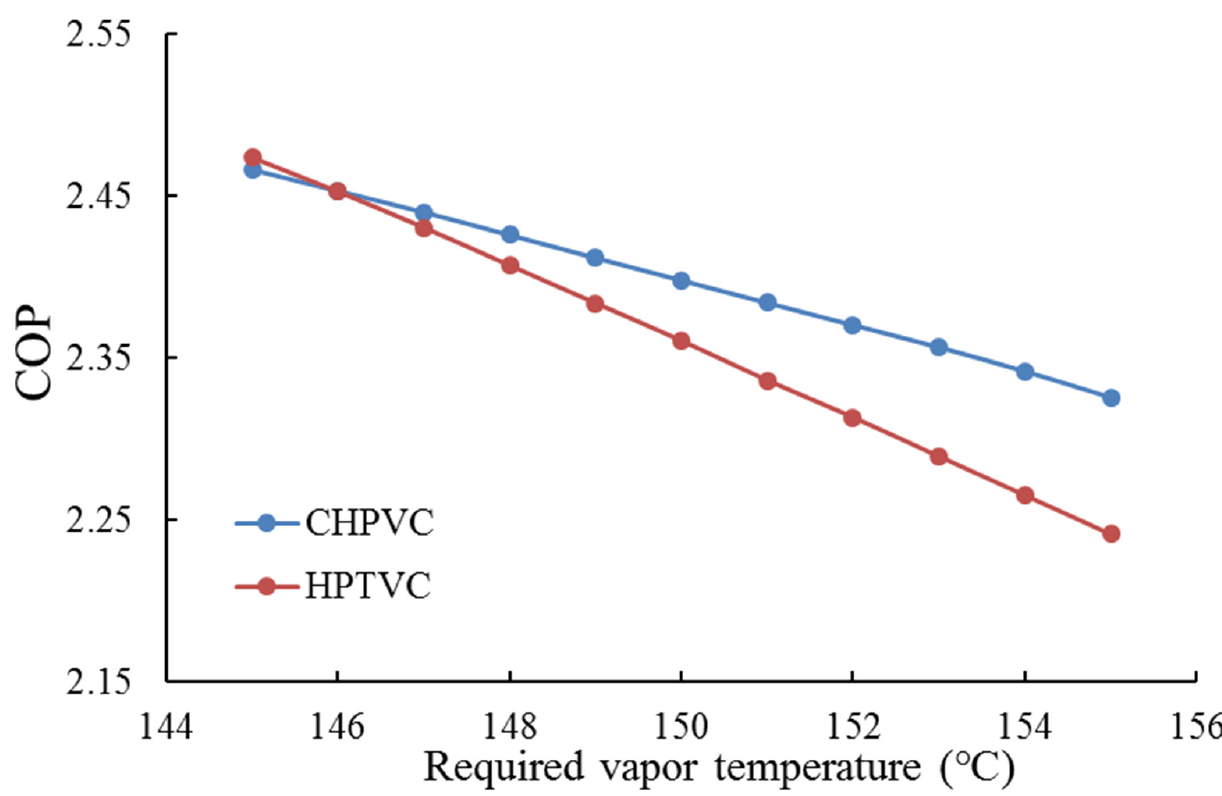
Figure 7. COP versus the required vapor temperature.